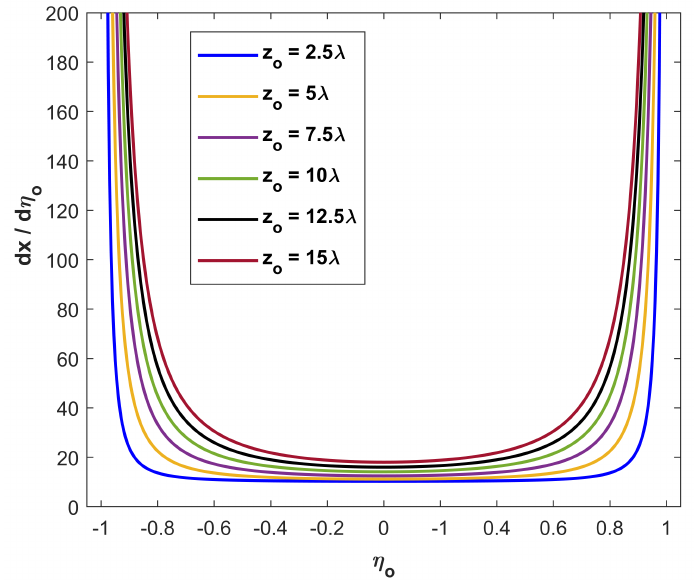
Figure A2. Diagram of dx in terms of η o for different values of z o . The picture refers to a source whose d η o semi-extension a is equal to 10 λ